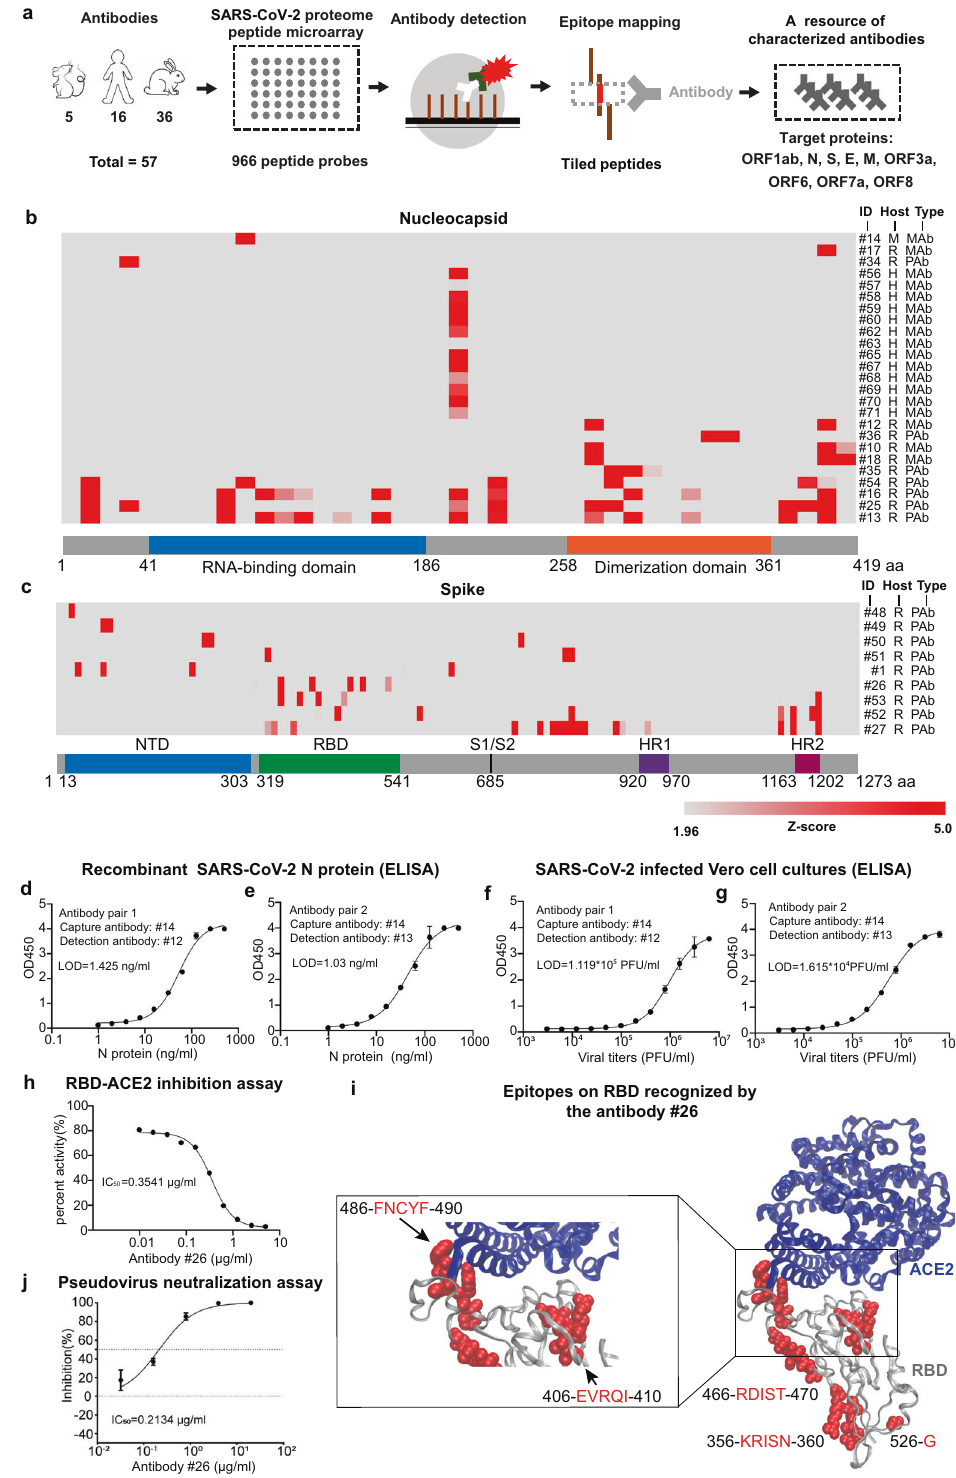
Fig. 1 The epitope pro fi ling database constructed by using a peptide-based SARS-CoV-2 proteome microarray and its application. a Schematic illustration of epitope mapping using a peptide-based SARS-CoV-2 proteome microarray. b , c Distribution of antibody epitopes within the N and S proteins respectively. The x -axis represents the protein sequence. The y -axis represents the identi fi cation (ID) number (#number), host (mouse = M, rabbit = R, human = H) and clonality of the antibody (polyclonal antibody = PAb, monoclonal antibody = MAb). d , e Detection of the puri fi ed, full-length recombinant N protein using ELISA prepared with two antibody pairs selected from epitope mapping analyses. f , g Detection of the N protein from inactivated SARS-CoV-2 in cell culture using ELISA prepared with two antibody pairs selected from epitope mapping analyses. h The neutralization activity of antibody #26 using an S-RBD-ACE2 inhibition assay. i Structural analysis of the antibody #26 epitopes on SARS-CoV-2 RBD (PDB ID: 6m0j). j Neutralization activities of antibody #26 using a pseudovirus